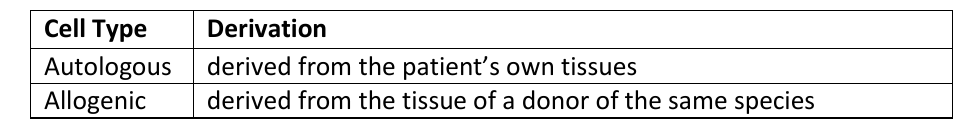
Table 1: Definition of type of MSC in relation to the